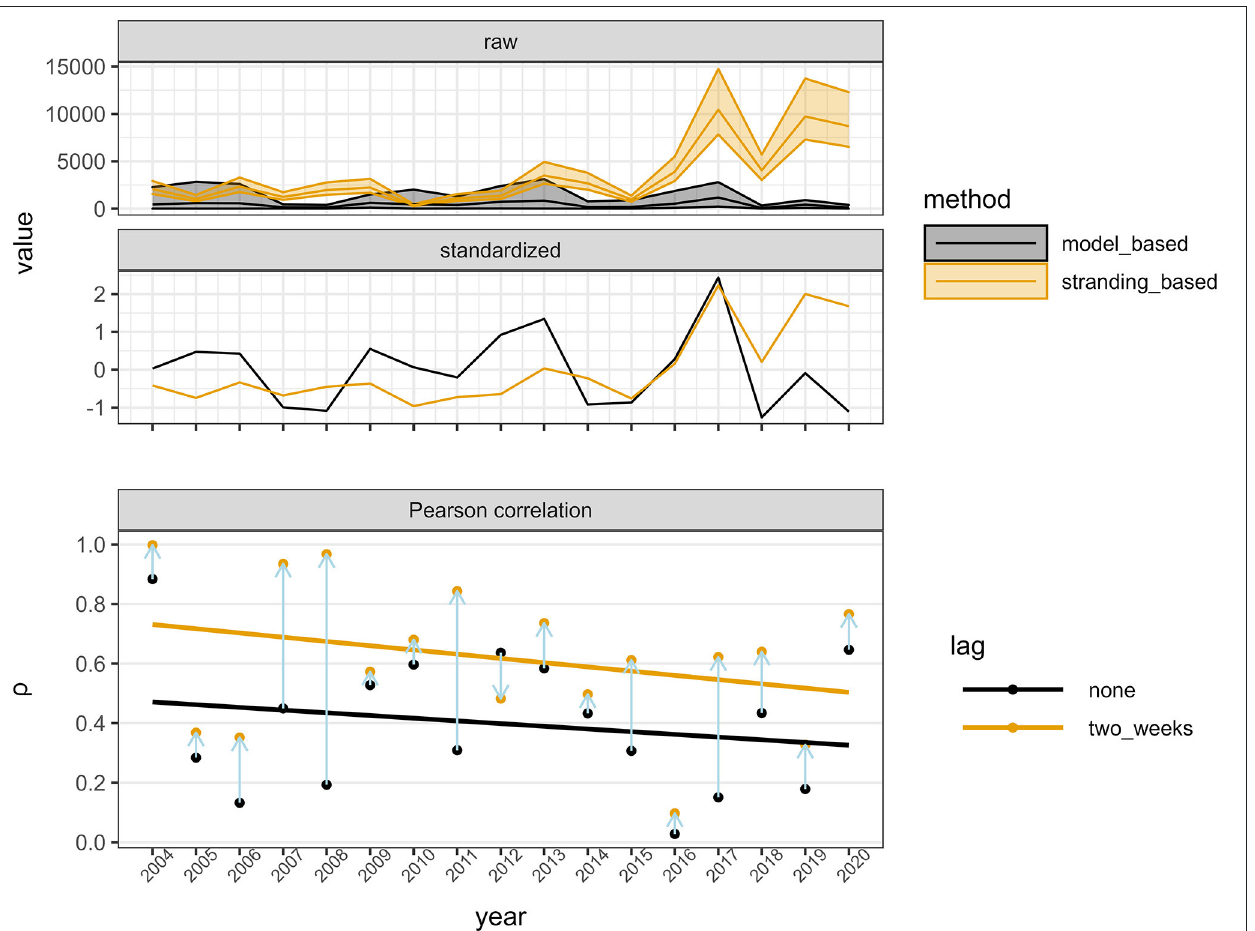
FIGURE 4 | Comparison of model-based (orange solid line) and stranding-based estimates (dark violet solid line) of common dolphin bycatch. Upper : Raw estimates with uncertainty intervals (80% for model-based estimates and 95% for stranding-based estimates); Middle : standardised (mean centred and unit variance) estimates. Bottom : Year-level and month-level (within each year) correlations were computed. At the within year (between month level), correlations were computed with and without 2-weeks lag. Change in the magnitude of the Pearson correlation coefficient is shown with an